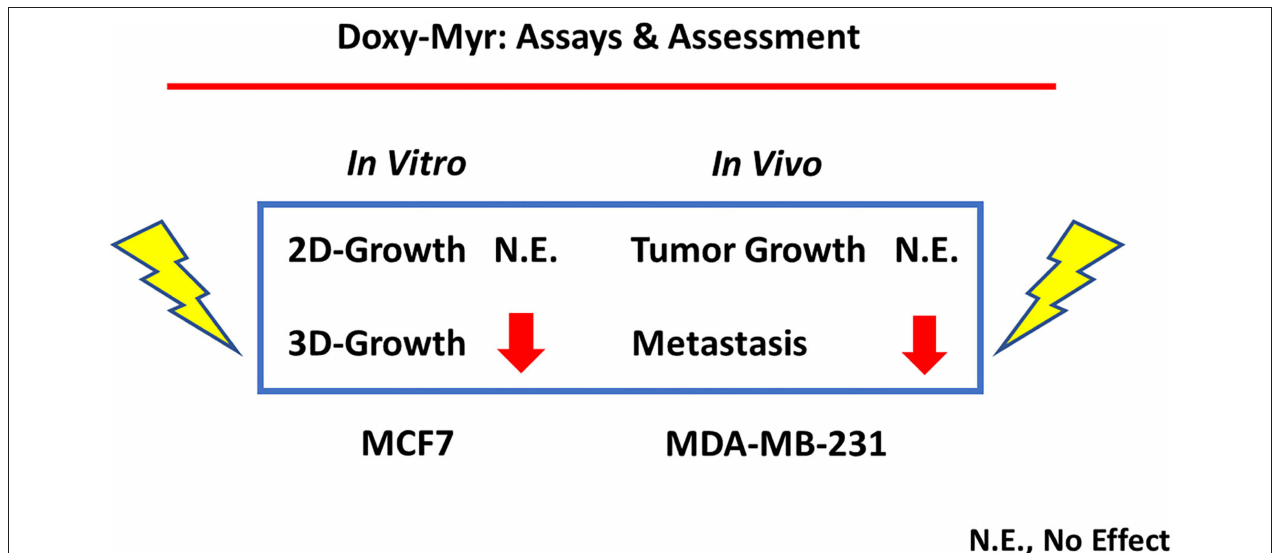
FIGURE 13 | In vitro inhibition of 3D-growth predicts in vivo inhibition of metastasis. Here, we used two complementary breast cancer cell lines for our in vitro screening (MCF7) and in vivo (MDA-MB-231) validation assays. More specifically, Doxy-Myr had no effect on 2D-growth in vitro and no effect on tumor growth in vivo . Conversely, we showed that Doxy-Myr potently inhibited 3D-growth in vitro , which directly correlated with inhibition of metastasis in vivo . In support of this observation, 3D anchorage-independent growth is thought to be a required step for metastasis in vivo . N.E., no effect.